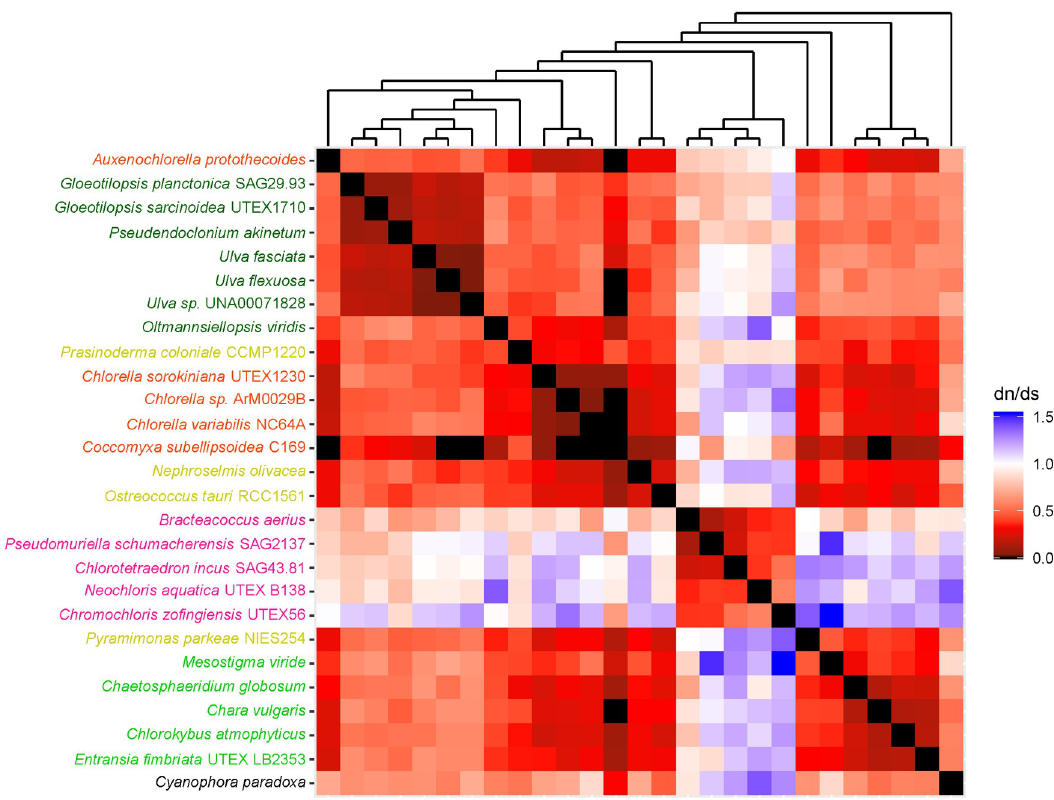
Fig 2. Heatmap of pairwise dN/dSdn/ds ratios calculated from alignment of mitochondrial atp 6. The scale bar showed the color corresponded to dN/dS ratios. The cladogram above the heatmap corresponds to its single-gene phylogenetic tree.